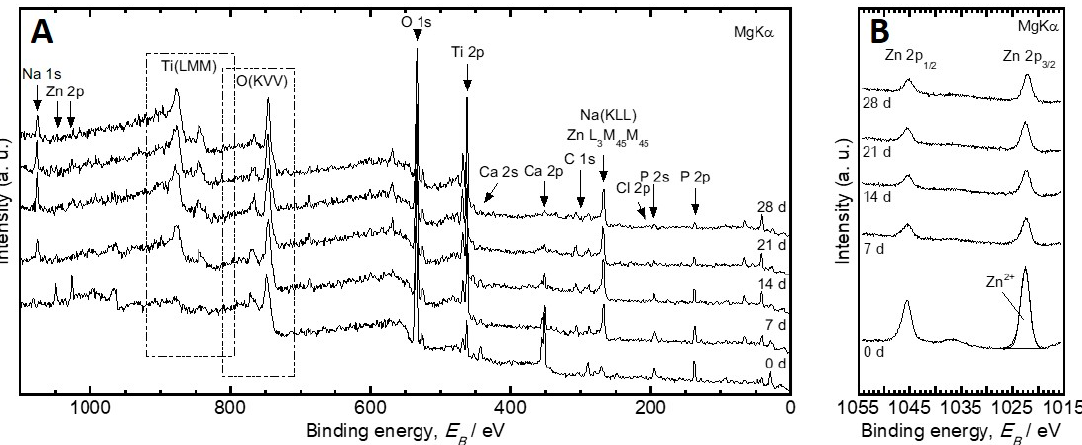
Figure 3. X-ray photoelectron spectroscopy (XPS) spectra of survey ( A ) and Zn 2p photoelectron energy region ( B ) from specimens immersed in saline for 0–28 days.